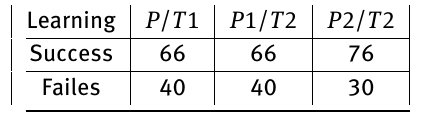
Figure 19: The figure displays the mean of the minimum of iteration of matching to find the target object for the robot population over the 106 test images (the lowest being the best). Table 4: Detailed results of testing on 106 images.